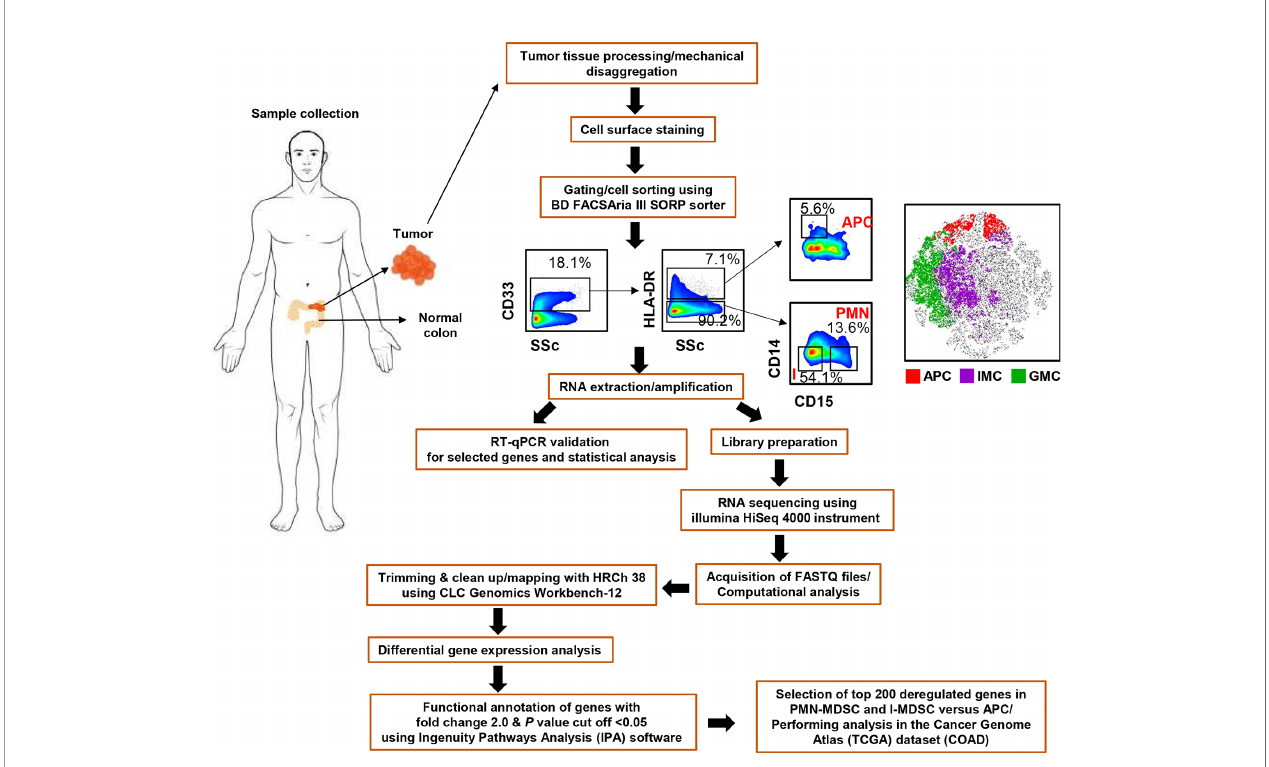
FIGURE 1 | Pipeline for the experimental design and RNA-Seq analysis. Flow chart showing the study design, gating strategy used for cell sorting and bioinformatic tools used for RNA-Seq data